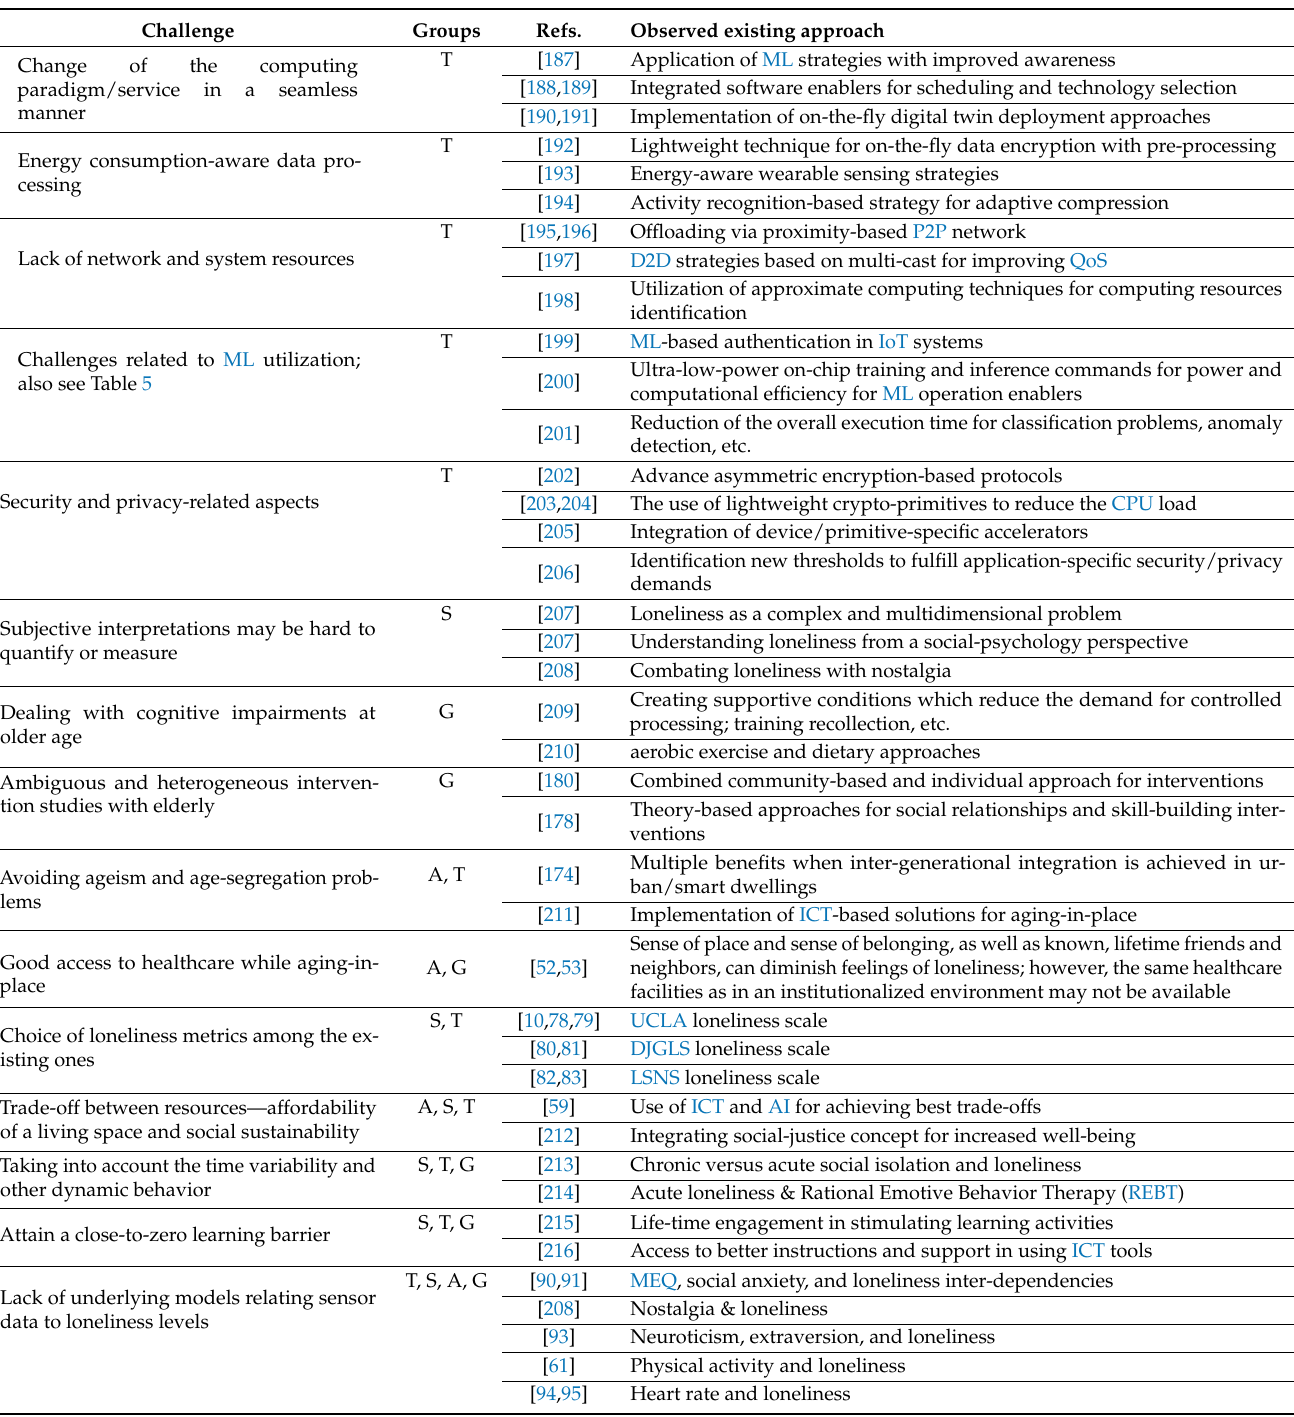
Table 7. Summary of the main identified challenges in loneliness management and monitoring in older